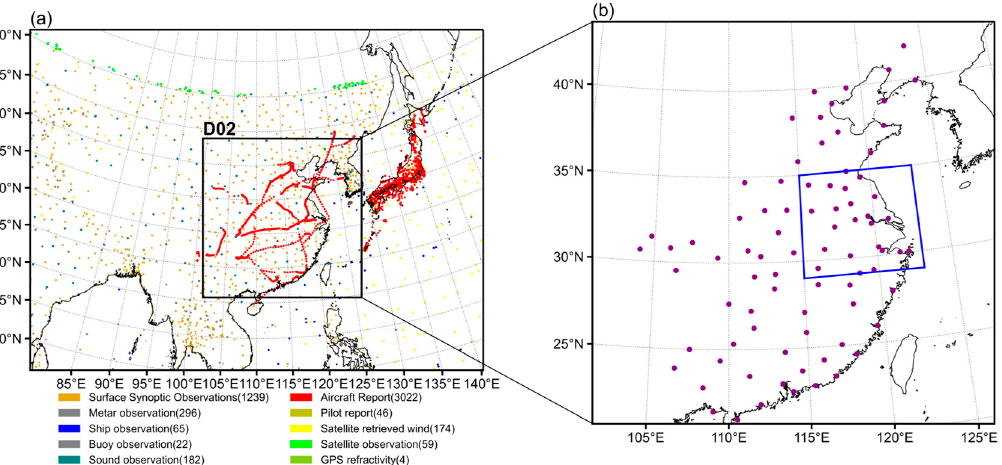
Figure 4. Model grid configuration and observation stations distribution. ( a ) Domain configuration and the conventional observation stations distribution; ( b ) D02 configuration and the radar observation stations (purple points), where the blue box is the evaluation area in cycling data assimilation and forecasting experiments.